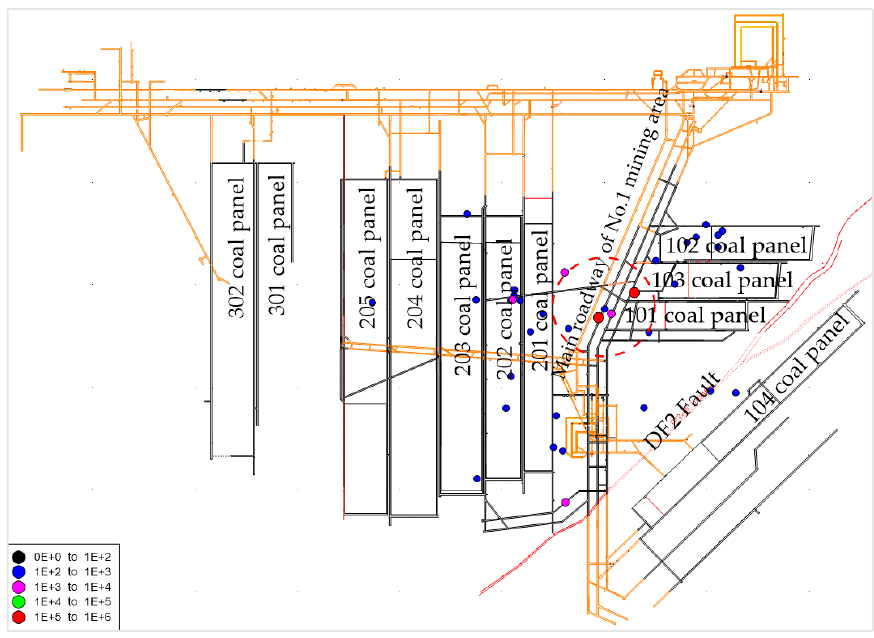
Figure 2. Microseismic Distribution Diagram on 27 September when Rock Burst Occurred.